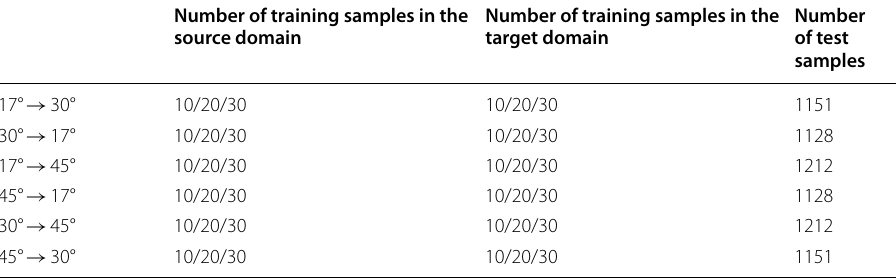
Number of training samples in the target domain